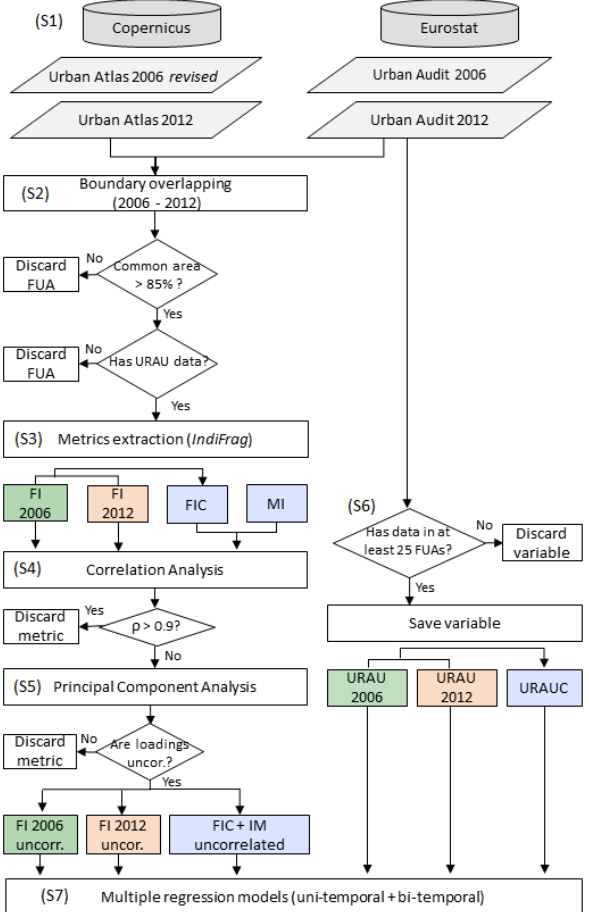
Figure 2. Step-by-step work flow from data collection to modelling. (S1) Urban Atlas and Urban Audit datasets are obtained from Copernicus and Eurostat databases; then (S2) an analysis is conducted to determine functional urban areas (FUA) with comparable boundaries and socio-economic data (URAU); (S3) using IndiFrag , metrics are computed for 2006 (FI 2006), 2012 (FI 2012), together with their differences (FIC) Figure 1. Location of the 68 selected FUAs according to the and multi-temporal indices (MI); (S4) the most correlated area coherence restriction imposed (>85% of common area), metrics are filtered out; and (S5) the uncorrelated indices are and statistical data available. The countries involved are: extracted; (S6) URAU variables based on the amount of data Bulgaria (BG), Germany (DE), Estonia (EE), Greece (EL), are selected and their differences are assessed (URAUC); Spain (ES), Lithuania (LT), Latvia (LV), Netherlands (NL), finally, (S7) uni-temporal models (URAU 2006 with FI 2006, Romania (RO), Slovenia (SI), Slovakia (SK), and United and URAU 2012 with FI 2012), and bi-temporal models Kingdom (UK). Data source: GISCO - Eurostat (European (URAUC with FIC and MI) are Commission).